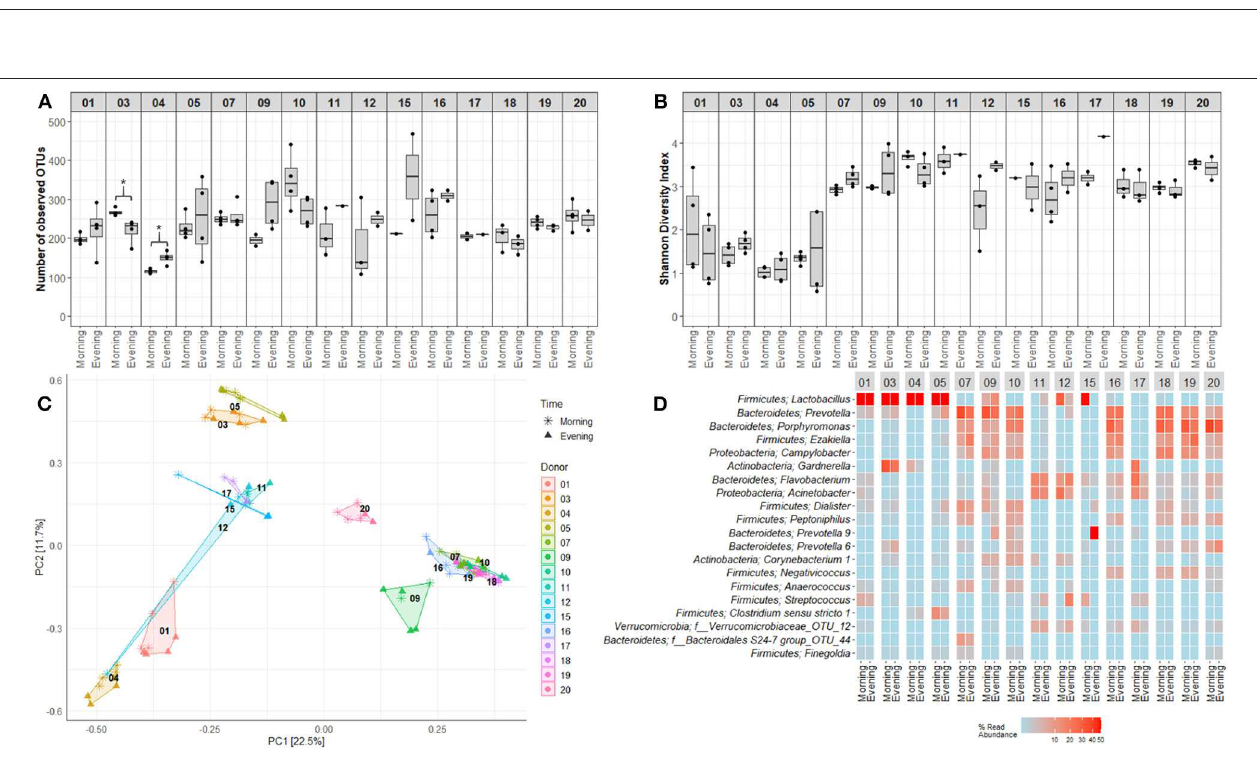
Frontiers in Cellular and Infection Microbiology |